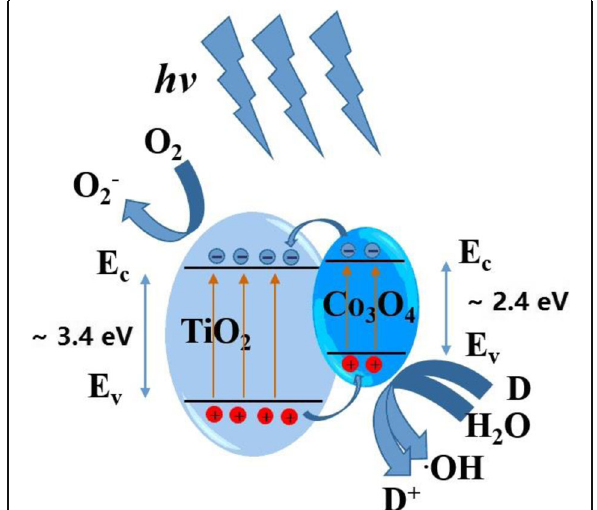
Fig. 7 Schematic of energy level and electron-hole movement in